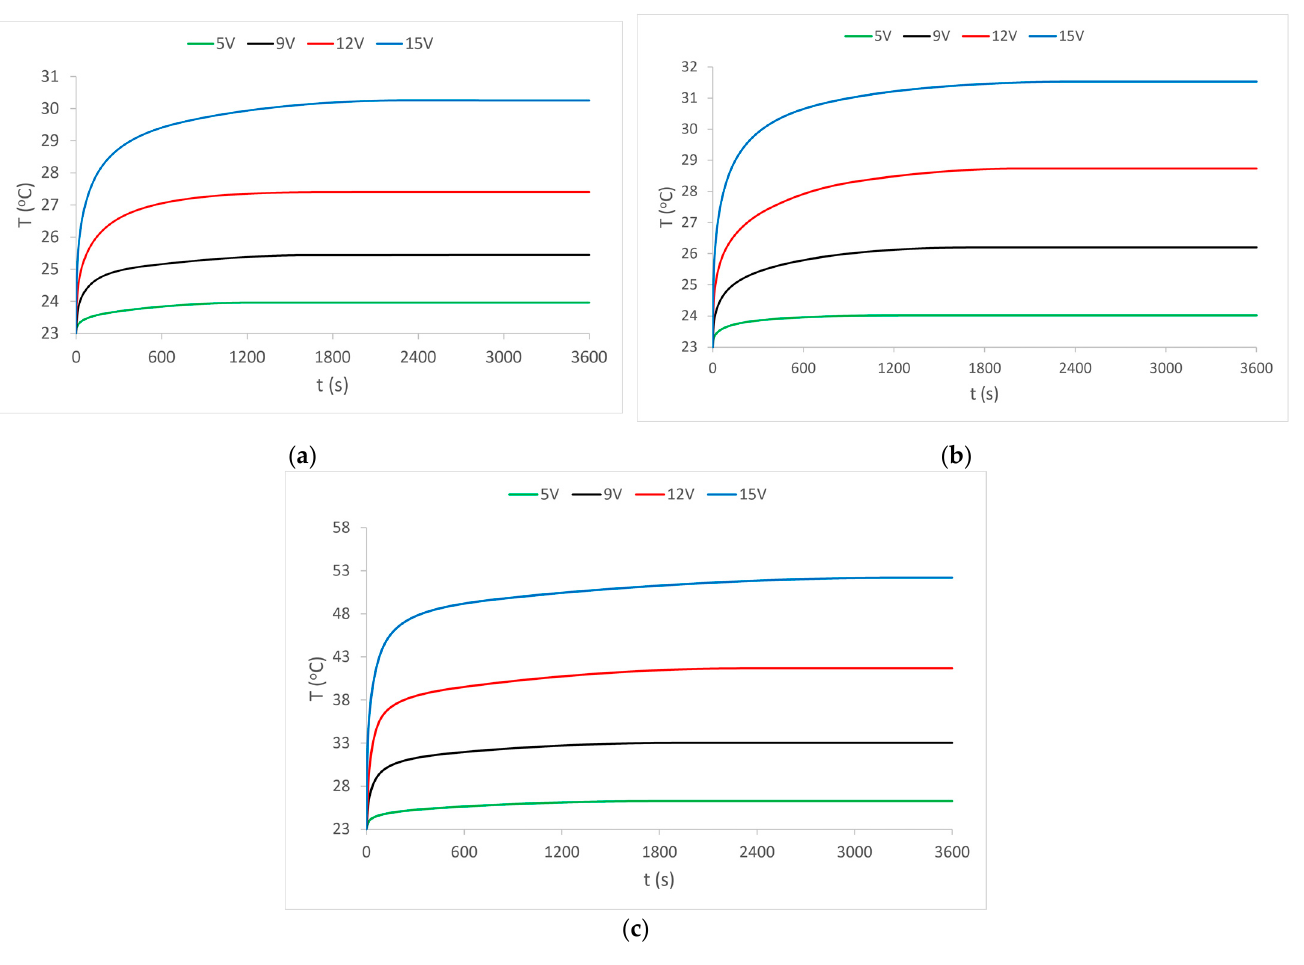
Figure 3. Temperature movement of the electrically conductive part of the sample at certain volt- ages: ( a ) sample 1; ( b ) sample 2; ( c ) sample 3. ( a ) sample 1; ( b ) sample 2; ( c ) sample